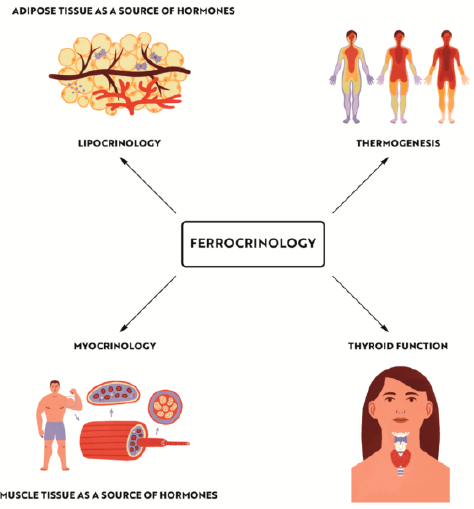
Figure 6. “Ferrocrinology” is the term proposed by us to describe the study of the effects of iron on metabolism disorders, endocrinopathies as AITD and mutual interactions of adipose and muscle tissues with it's influence on thermoregulation disturbances.